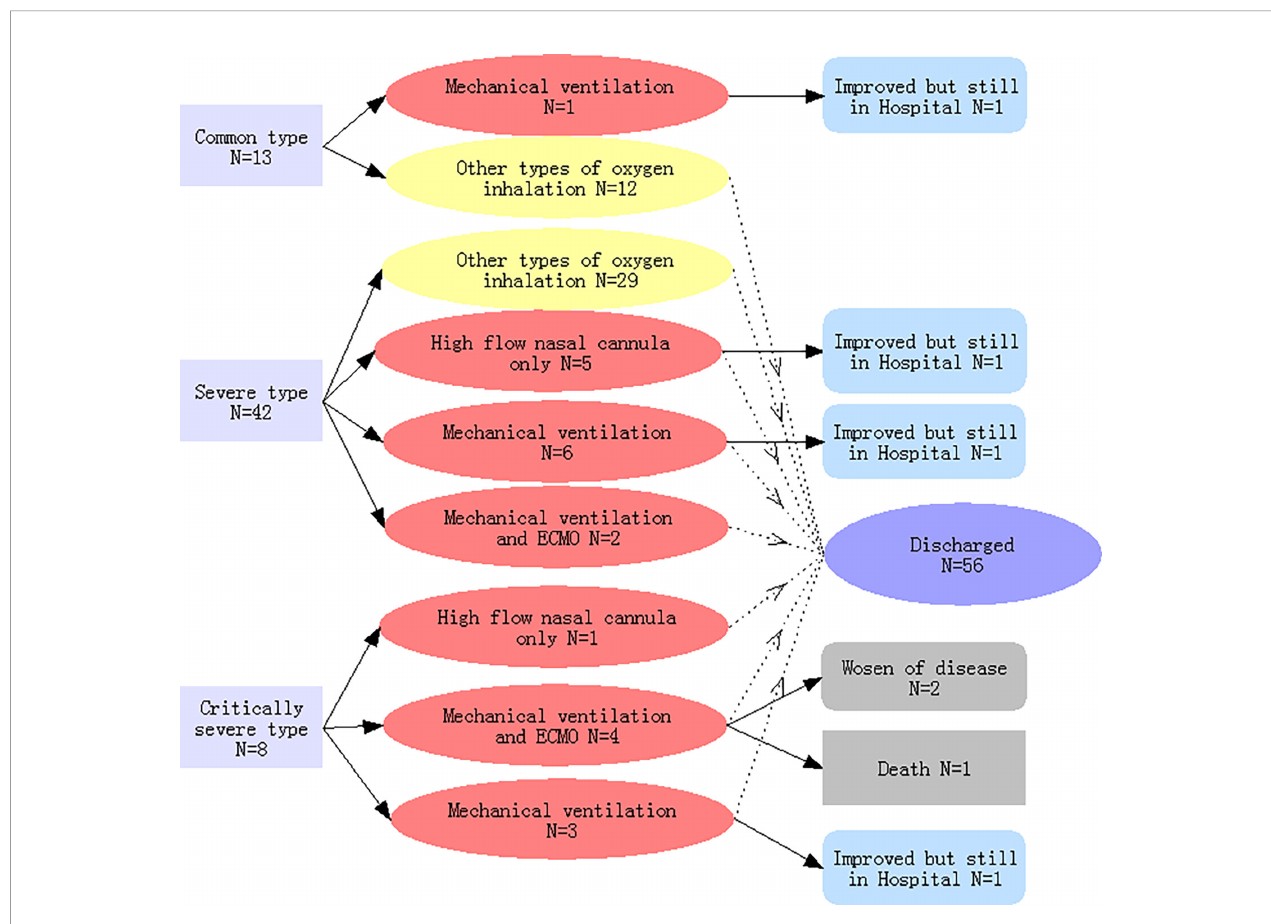
FIGURE 1 | Classi fi cations of the severity of COVID-19-related pneumonia on admission, types of oxygen inhalation, and clinical outcomes. Light yellow indicates COVID-19 pneumonia patients with non-critical illness; light red indicated patients with critical